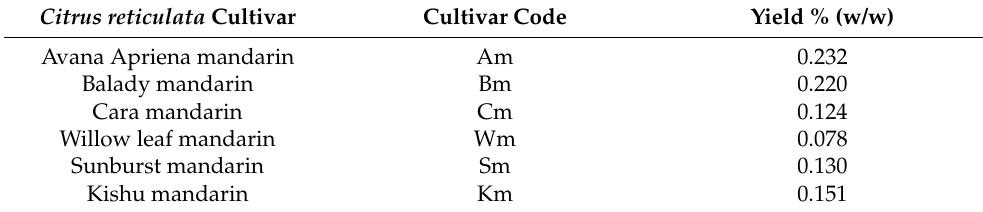
Table 1. Citrus reticulata cultivars, codes, and yield % (w/w). Citrus reticulata